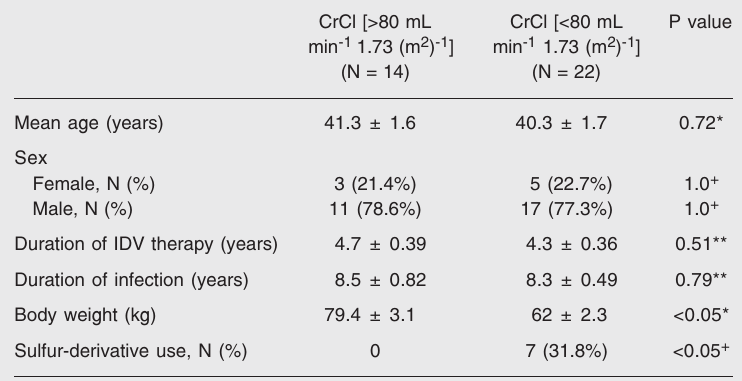
Table 1. Demographic and clinical characteristics of the 36 subjects studied.